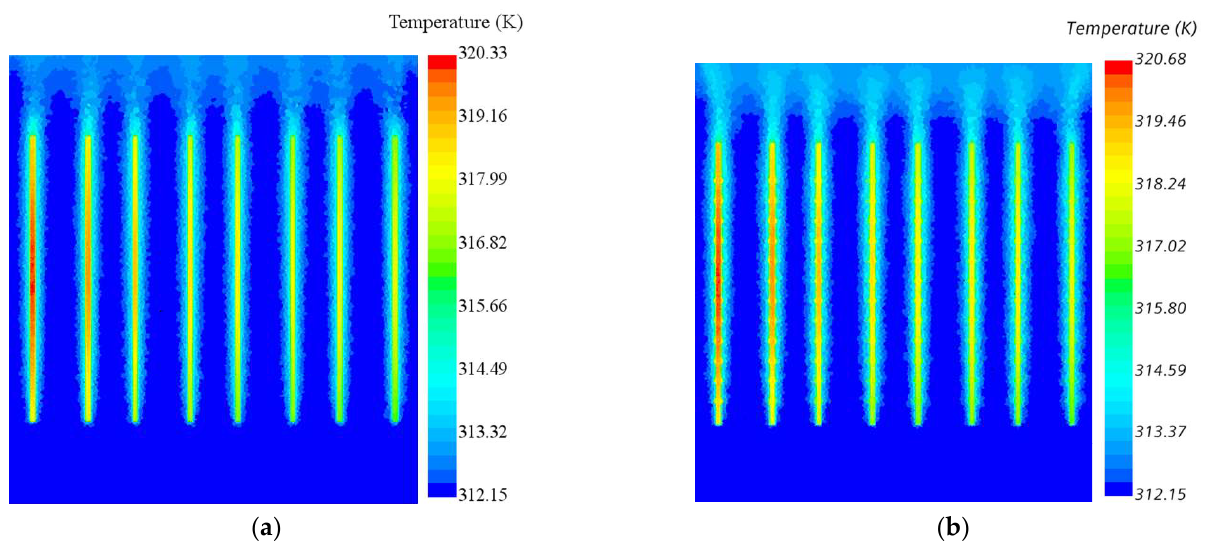
Figure 11. Temperature contour comparison between ( a ) Hex0 and ( b ) Hex1.